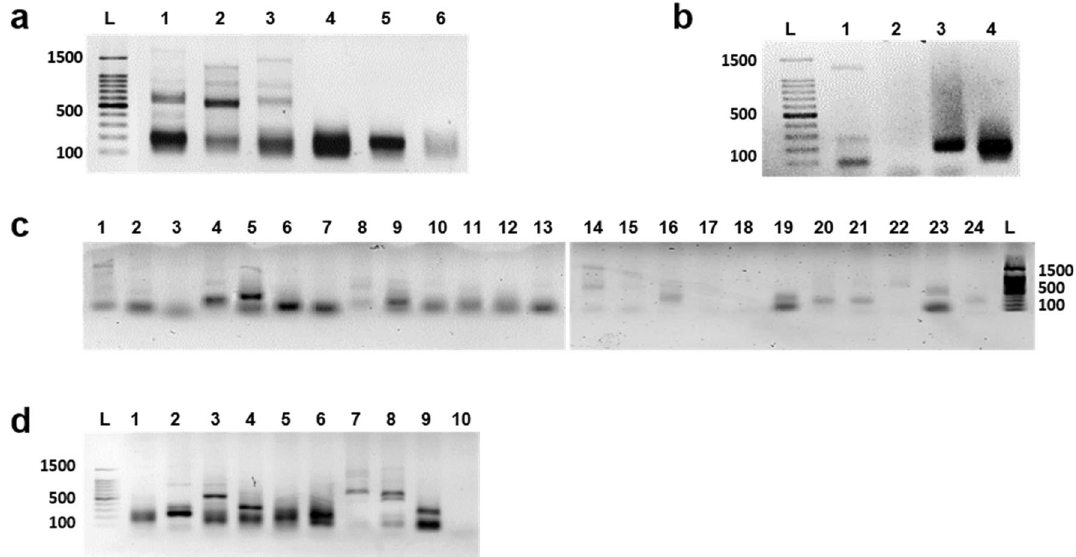
Figure 5. Testing the specificity of SSR primers. ( a ) Amplification of LafMS02 primer. L-100 bp molecular weight marker 1: Elephant dung DNA (from the mucus layer) 2: Fibers taken from inside of the bolus 3: Fibers taken from multiple samples 4: Mixture of Plant DNA ( C. zeylanicum , O. rhizomatis , S. album and S. zeylanica ) 5: Elephant Blood DNA (from elephant no: 66) 6: Negative control-water. ( b ) Amplification of EMU14 primer. L-100 bp molecular weight marker 1: Elephant dung DNA (from the mucus layer), 2: Fibers taken from inside of the bolus 3: Mixture of Plant DNA ( C. zeylanicum , O. rhizomatis , S. album and S. zeylanica ), 4: Elephant Blood DNA (from elephant no: 66). ( c ) Amplification of plant DNA with 24 primers.1: EMU03, 2: EMU04, 3: EMU06, 4: EMU07, 5: EMU10, 6: EMU09, 7: EMU11, 8: EMU12, 9: EMU13, 10: EMU14, 11: EMU15, 12: EMU17, 13: LafMS02, 14: LafMS06, 15: LA2, 16: LA3, 17: LA4, 18: LA5, 19: LA6, 20: EMX-1, 21: EMX-2, 22: EMX-3, 23: EMX-4, 24: EMX-5, L-100 bp ladder. ( d ) Amplification of plant DNA with nine selected primers (repeated PCR). L-100 bp ladder 1: EMU07, 2: EMU09, 3: EMU10, 4: EMU13, 5: EMU14, 6: EMU15, 7: LafMS06, 8: EMX-4, 9:LA6, 10: Negative control (water). Full-length gels are presented in Supplementary Figure